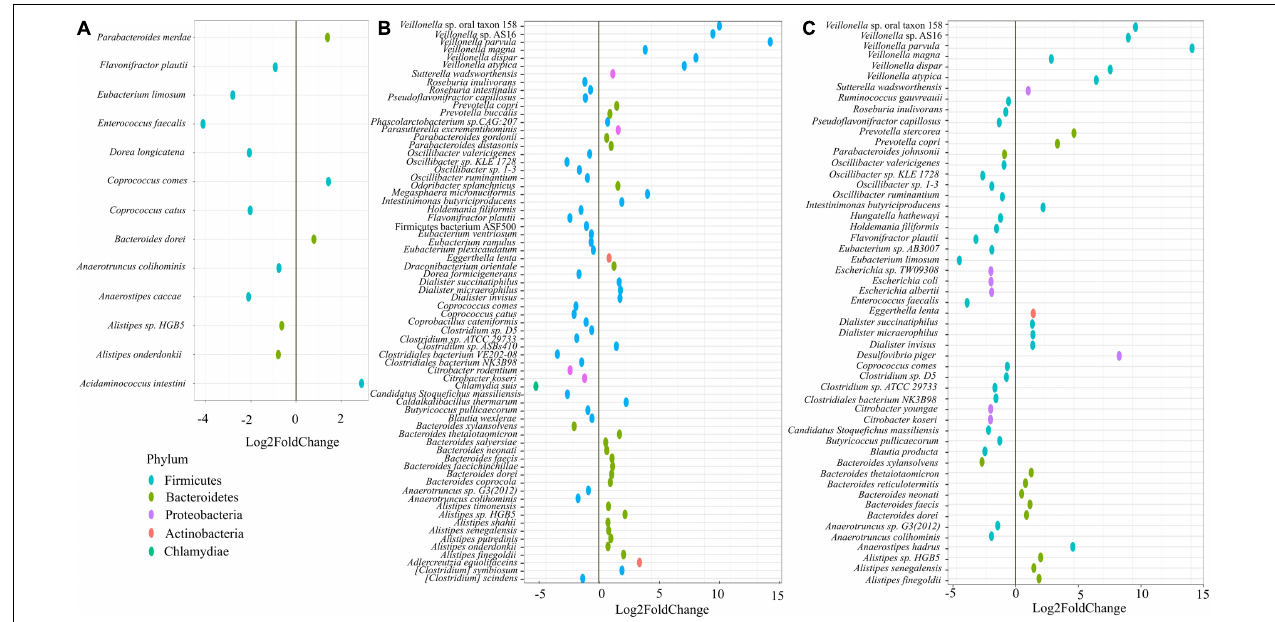
FIGURE 3 | Impact of quercetin and rice bran supplementation on microbiota bacterial species. Bacterial species that are significantly altered in (A) quercetin (QC), (B) rice bran (RB), and (C) QC + RB when compared to the control medium. The differential significance of the species was calculated by using DESEq2 ( Supplementary Table 1 ) from shotgun metagenome sequence analysis at day 21. The left column represents bacterial species-level taxa while the colors indicate their corresponding phyla (“Blue” = Firmicutes , “Brown” = Bacteroidetes , “Pink” = Proteobacteria , “Orange” = Actinobacteria , “Green” = Chlamydiae